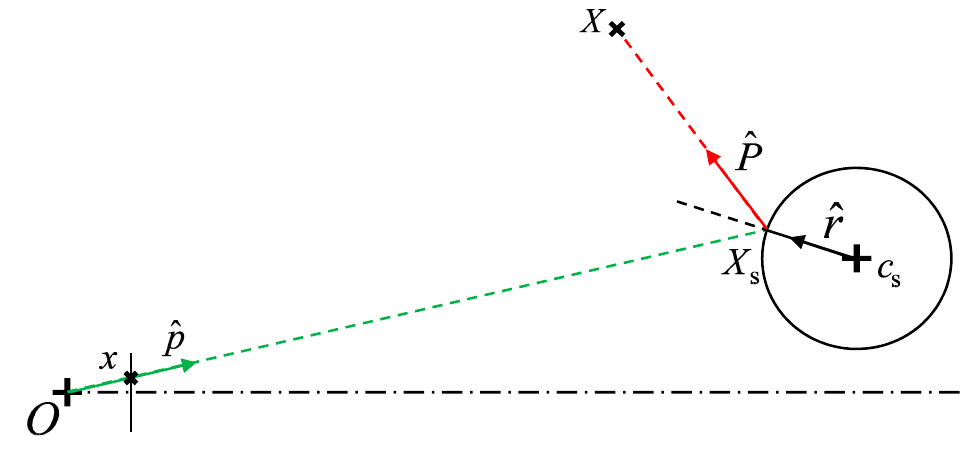
Figure 2. Backward projection geometrical scheme.